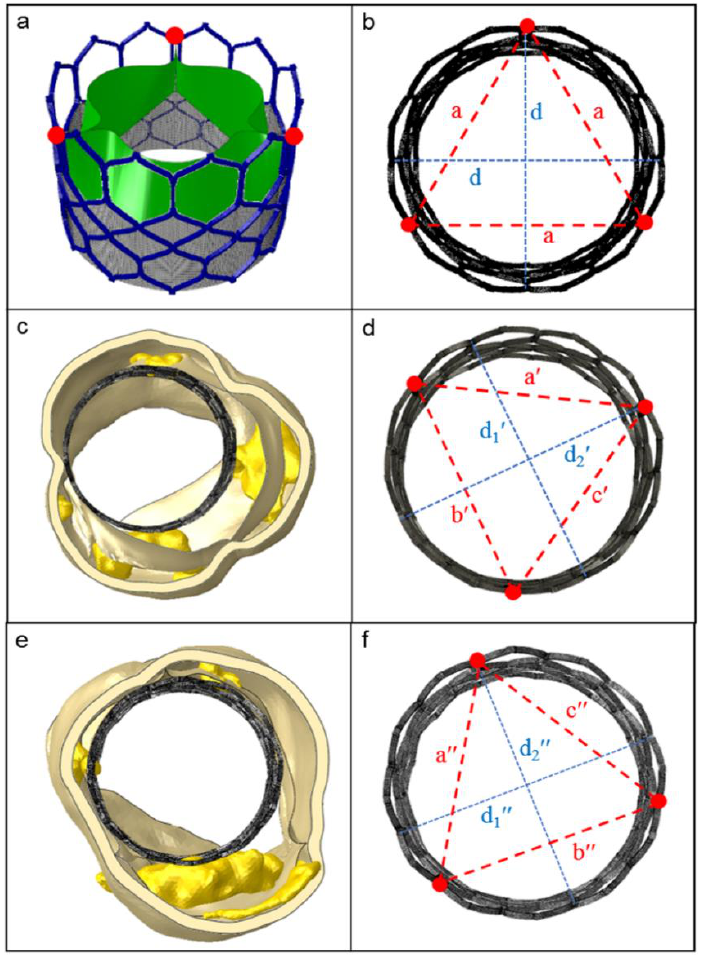
Figure 6. The ideal shape of a Sapien 3 stent frame (upper panels) compared to the real ones after implantation in patients under study. ( a ) Open device configuration before crimping; ( b ) perfect frame circularity, when the two principal axes d have the same length, such as the triangle edges a (top view); ( c , e ) balloon-driven device re-expansion within the investigated patients (thrombotic and control case, respectively); ( d , f ) evaluation of the implanted stent deformation, proposed as the measure of the three distances between the points at the commissure windows (red dots). [ a ′ ≠ b ′ ≠ c ′ ≠ a ; a ″ ≠ b ″ ≠ c ″ ≠ a ; d 1 ′ and d 2 ′, d 1 ″ and d 2 ″: minor and major axes of the originated ellipses; d 1 ′ ≠ d 2 ′ ≠ d ; d 1 ″ ≠ d 2 ″ ≠ d ].